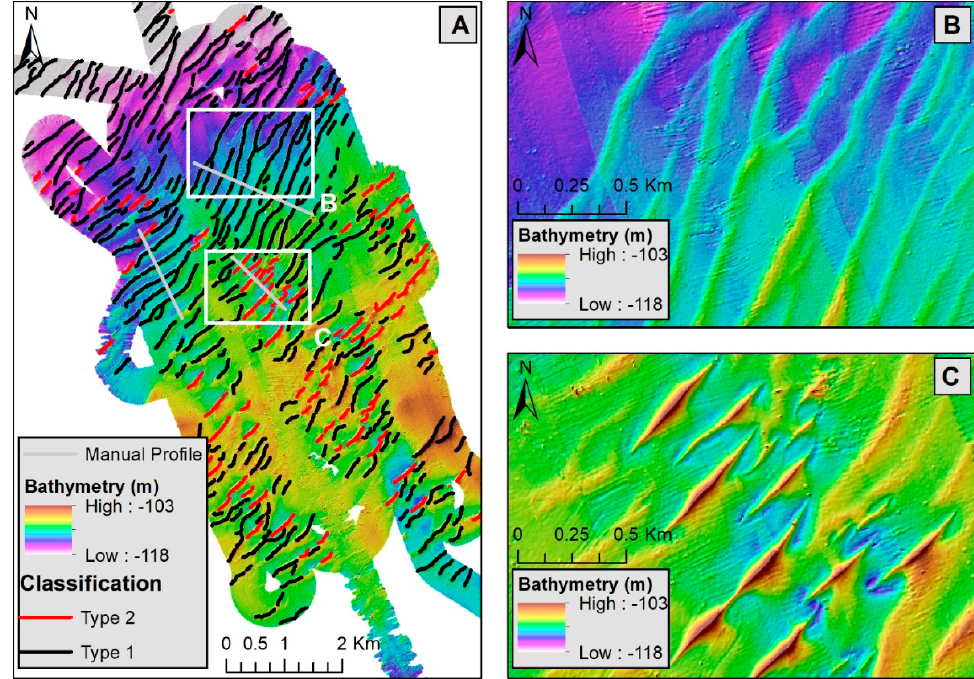
Figure 11. Broome AOI classification map ( A ). Two types of bedforms were discriminated using the cross-correlation of the metrics (see Figure 12) and are referred to as Type 1 ( B ) and Type 2 ( C ). Grey lines indicate the position of manual profiles used to compare manual and automated metrics.